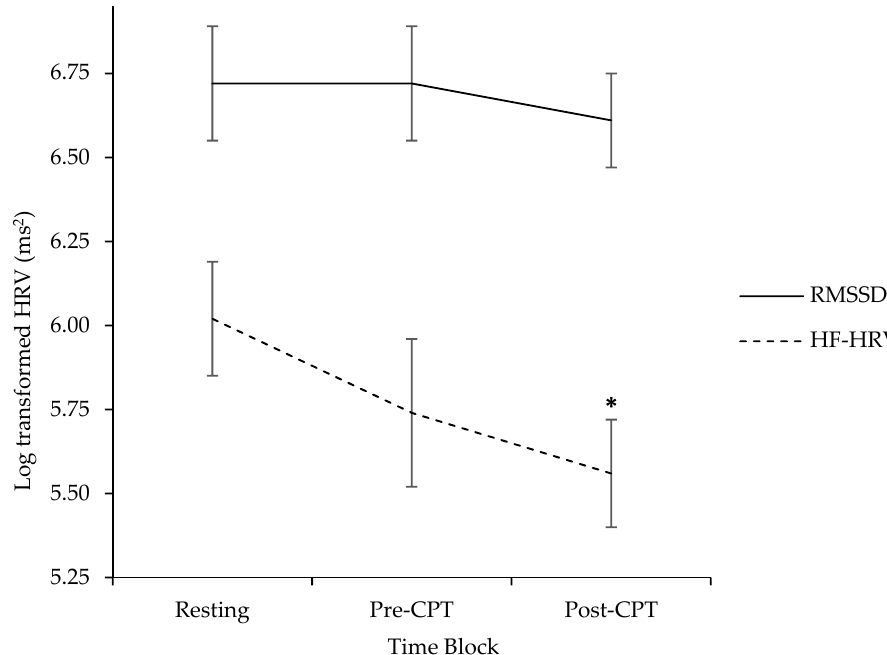
Figure 3. HF-HRV and RMSSD activity (log transformed ms 2 ) during resting, pre-CPT and post-CPT. Bars represent standard error. Asterisks indicate significant differences between blocks, * p < 0.05.